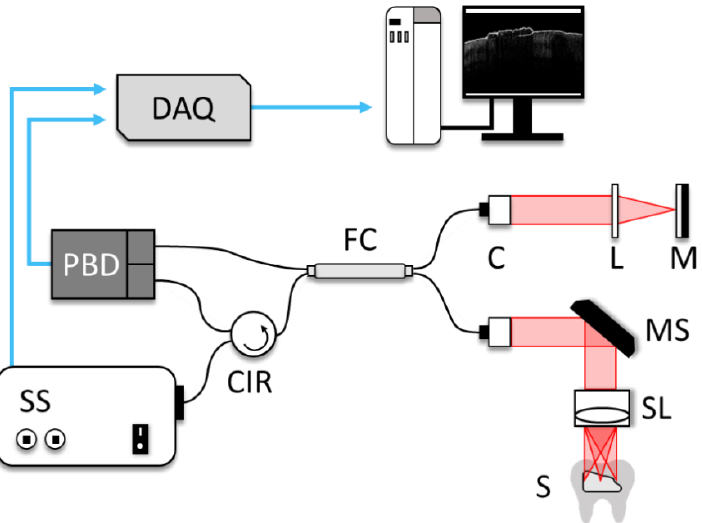
Figure 2. The schematic diagram of 1310 nm SS-OCT system. SS: swept-source, CIR: circulator, FC: fiber coupler, C: collimator, MS: MEMS scanner, L: lens, M: mirror, S: sample, SL: sample lens, BD: balanced detector.